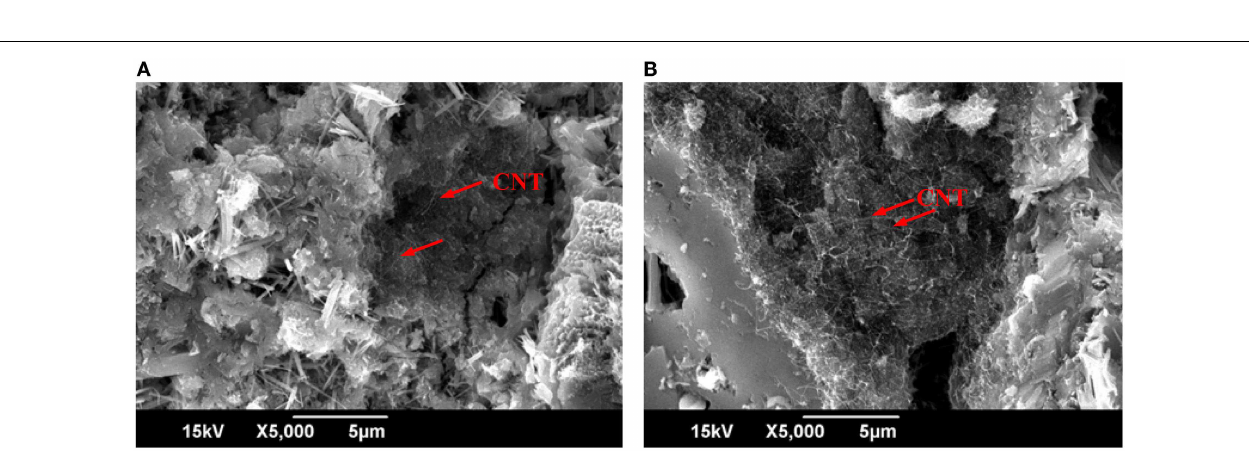
FIGURE 5 | SEM photographs of CNT filled cement mortar composites . (A) With NaDDBS and 1 wt.% of MWNT. (B) With SDS and 1 wt.% of